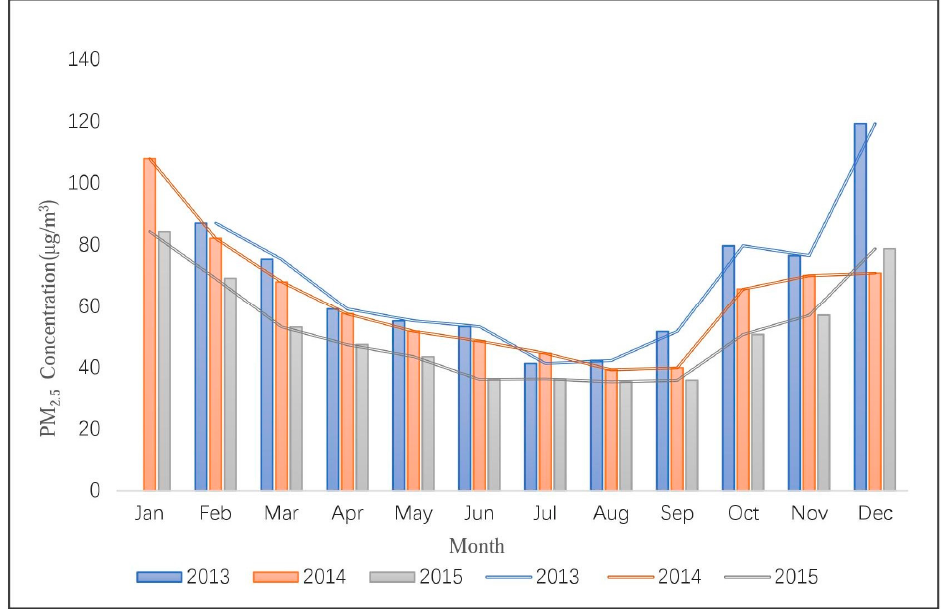
Figure 4. Temporal variation of PM 2.5 concentration from 2013 to 2015.